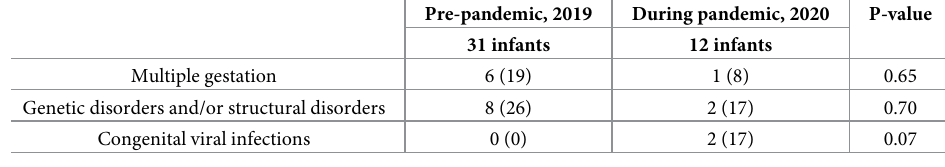
Table 3. Infant factors associated with fetal growth restriction.